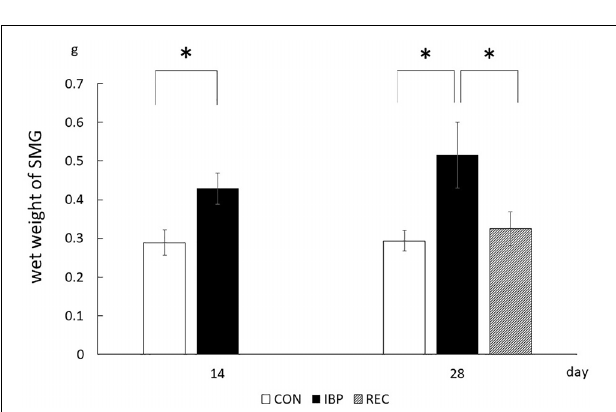
FIGURE 1 | Body weight of the rat in CON, IBP, and REC group. Changes in body weights during the experimental period in CON, IBP, and REC groups. Data are presented as means ± standard deviation ( n = 6 each).